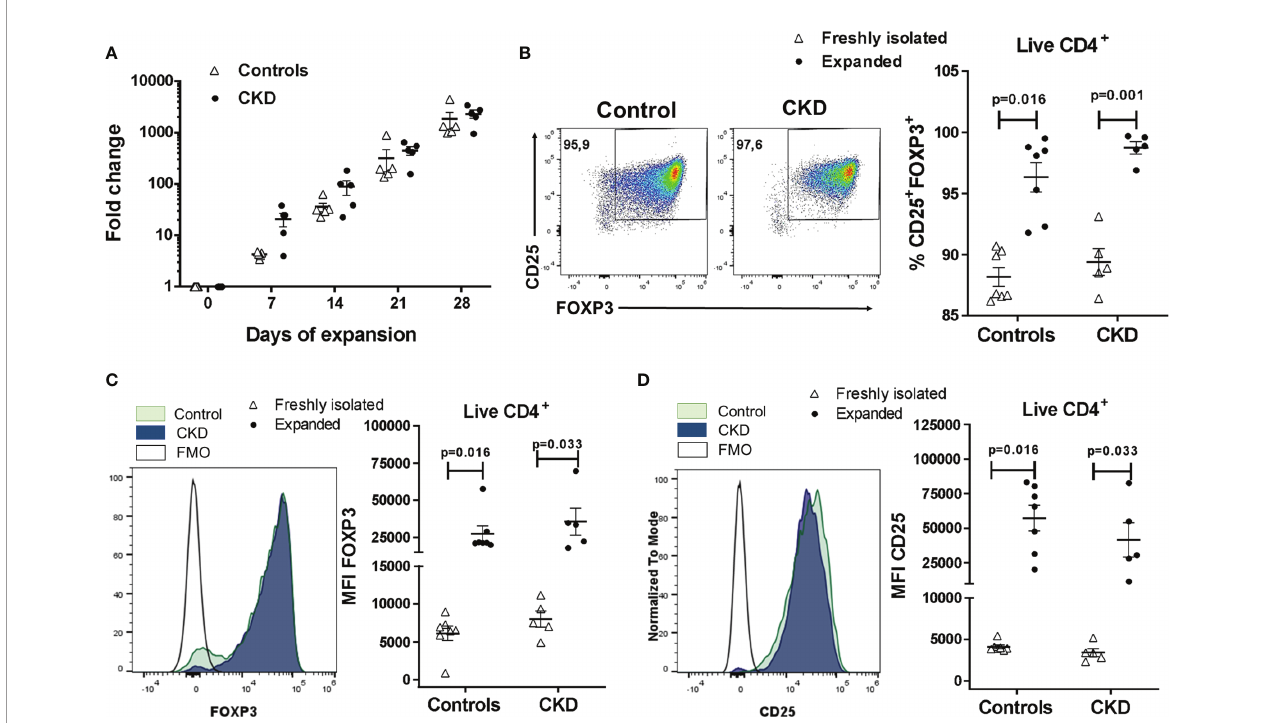
FIGURE 2 | Highly puri fi ed allospeci fi c regulatory T cells (Tregs) increased the expressions of FOXP3 and CD25 after ex vivo expansion. CD4 + CD25 hi CD127 − T cells [labeled with CellTrace Violet (CTV)] from healthy individuals ( white triangles , n = 7) or patients with chronic kidney disease (CKD) ( black circles , n = 5) were stimulated with allogeneic monocyte-derived dendritic cells (Mo-DCs). On day 7, CD4 + CD25 hi CTV − T cells (allospeci fi c Tregs) were puri fi ed and polyclonally expanded for 4 weeks; the expressions of FOXP3 and CD25 were evaluated by fl ow cytometry. (A) Allospeci fi c Tregs from patients proliferated to the same extent as the Tregs from healthy controls. Fold expansion was calculated by dividing the number of Tregs obtained on the evaluated day by the number of Tregs on day 0. (B – D) The proportion of CD25 + FOXP3 + cells (B) and the expressions of FOXP3 (C) and CD25 (D) were increased in the expanded alloantigen-speci fi c Tregs ( allo Tregs) in both study groups compared to those of freshly isolated Tregs. The median fl uorescence intensity (MFI) was calculated as described in Section 2.6 . Representative experiments are shown in (B – D) , and the white histograms represent FMO ( fl uorescence minus one) controls (C , D) . The results are shown as the mean ± SEM. Statistical analysis was performed using the Mann – Whitney U test or Wilcoxon ’ s rank-sum